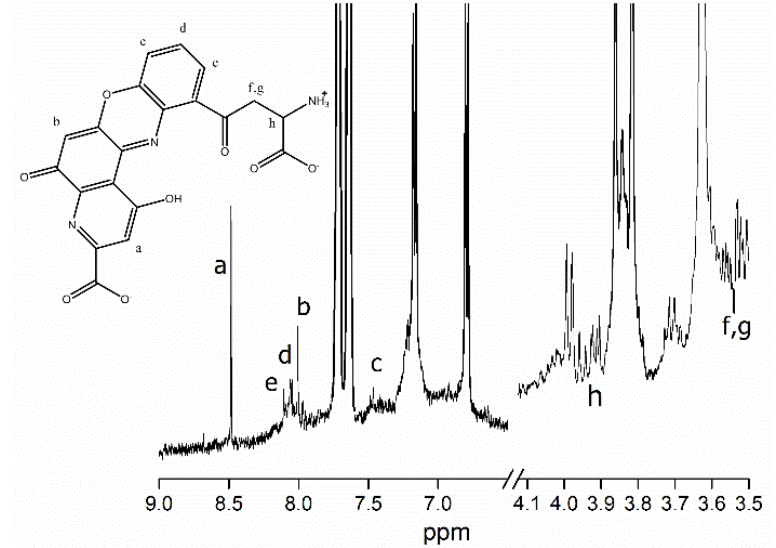
Figure 2. 1 H NMR spectra of fraction F7, which showed the highest activity in the DPPH, ABTS, and FRAP antioxidant assays.